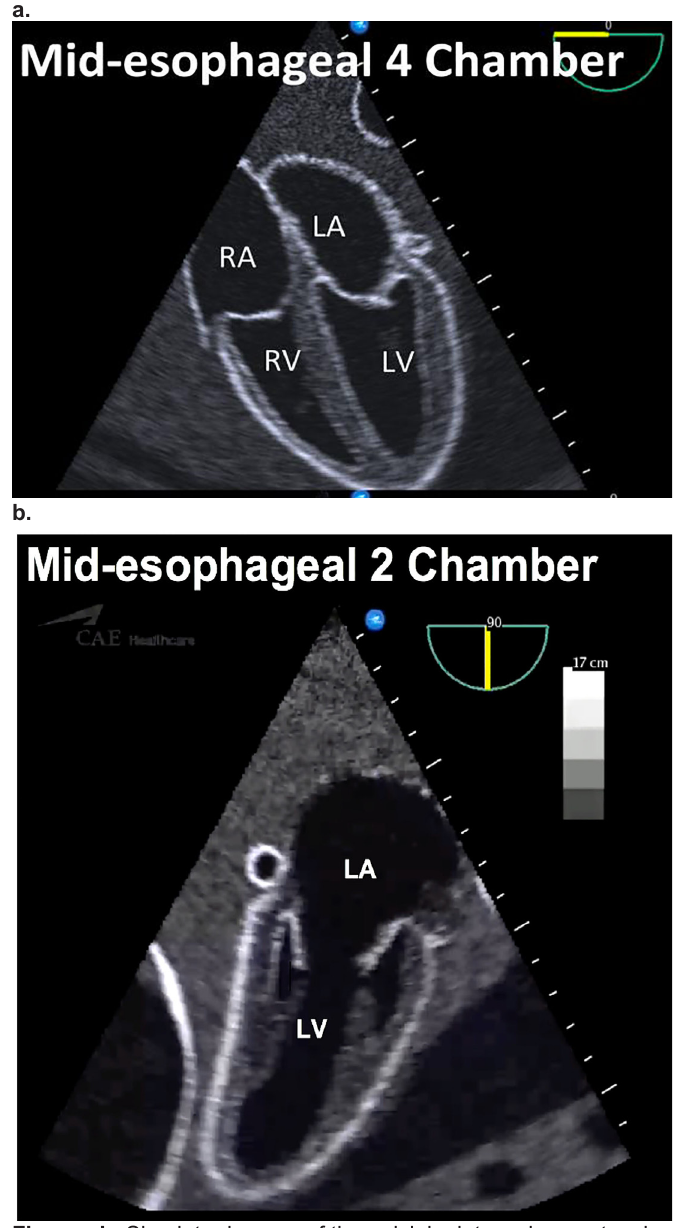
Figure ab. Simulator images of the quick look two-view protocol for transesophageal echocardiography RA, right atrium; LA , left atrium; RV , right ventricle; LV , left